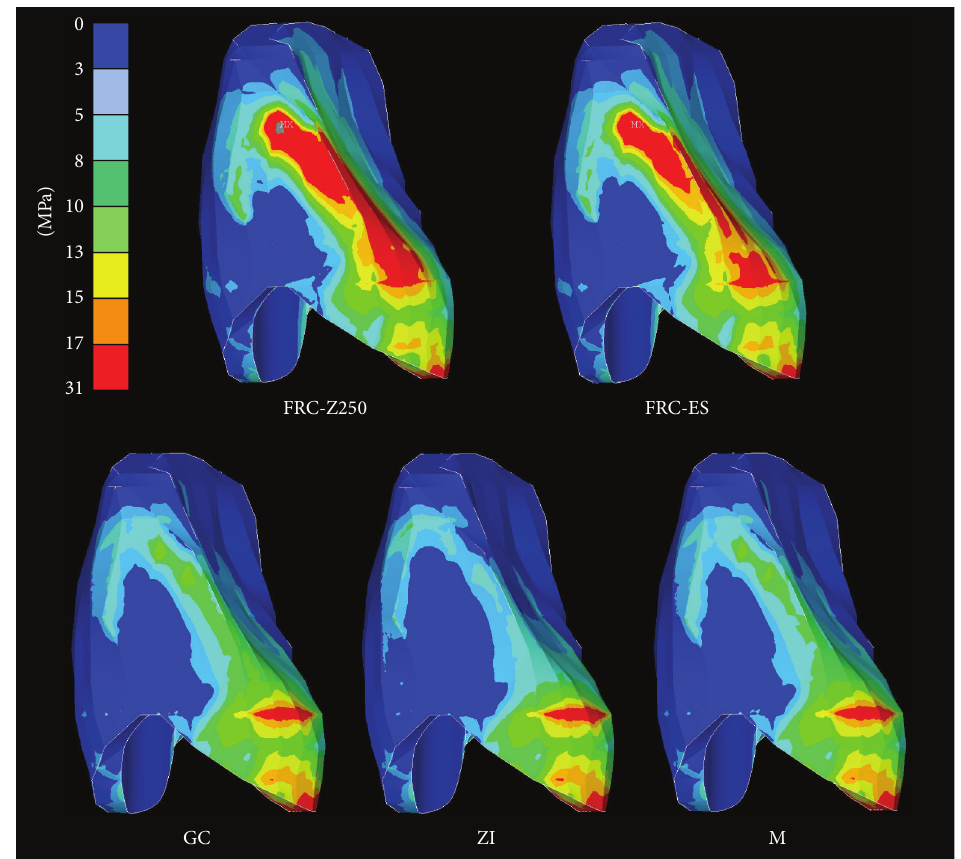
Figure 7: Principal stress distribution at the abutment tooth for two-unit cantilever RBFDPs of various framework materials.